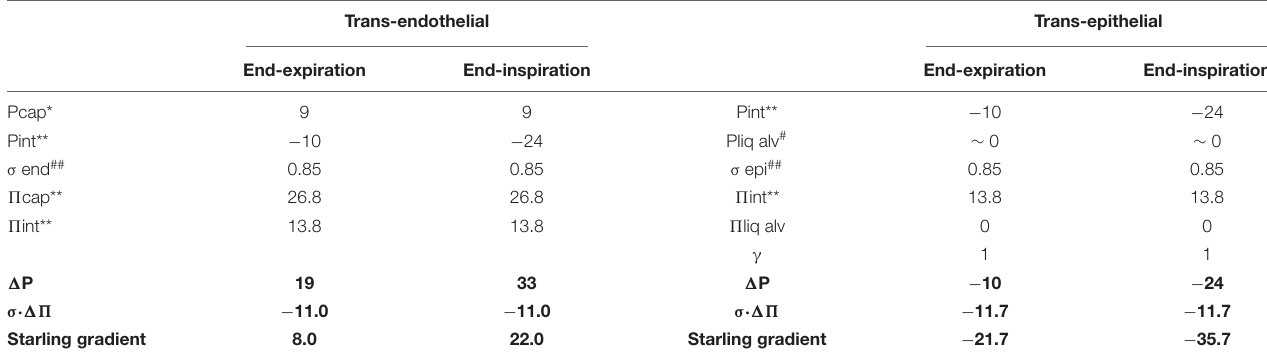
TABLE 1 | Trans-endothelial and trans-epithelial Starling pressure gradients at end-expiration (functional residual capacity, FRC) and end-inspiration under physiological conditions (referring to Point A in Figure 4